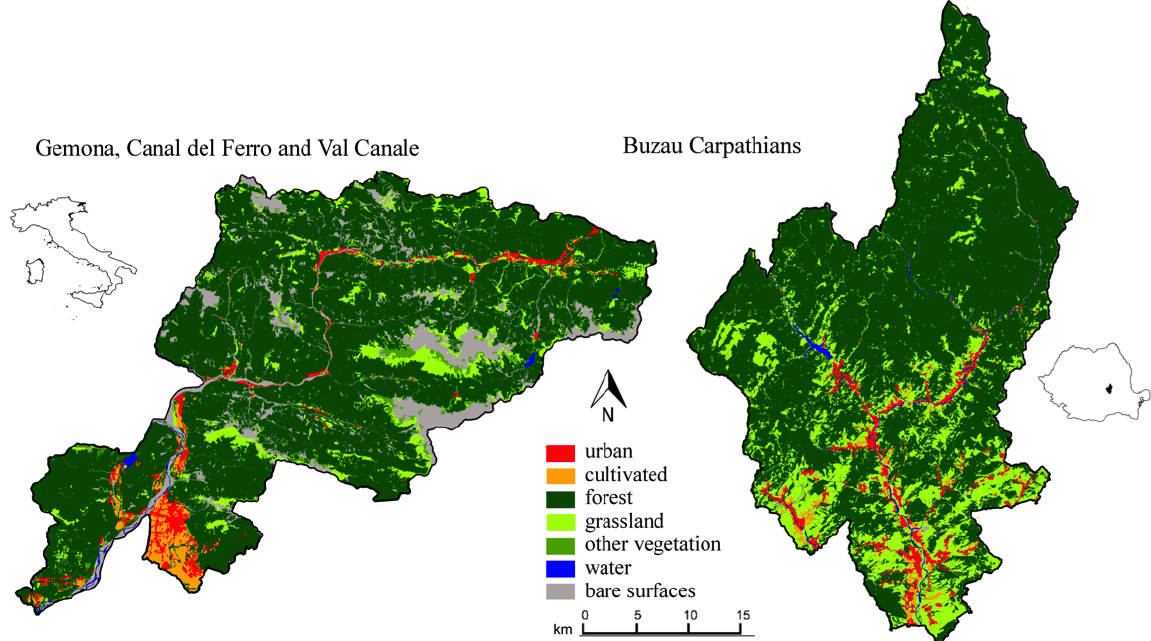
Figure 2. Classified land cover maps of the case study areas for